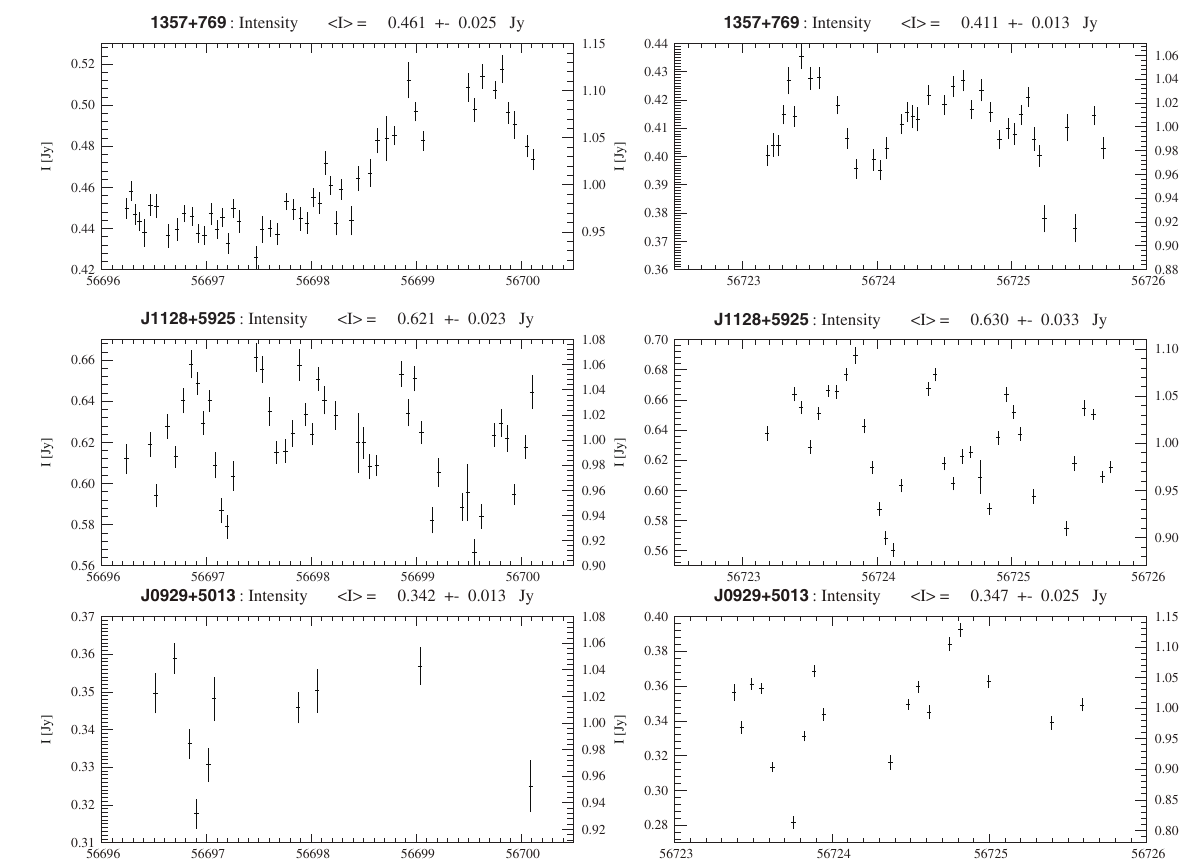
Figure 1. Three strong IDV sources with m 3 in both observations. ( Left upper panel ) the light curve of 1357 + 769 at ≥ 4.8 GHz in 8–12 February 2014, the flux density I (left y -axis) and the ratio of flux density over mean flux density < I > (right y -axis) versus time (MJD) in this and following figures; ( right upper panel ) the light curve of 1357 + 769 at 4.8 GHz in 7–9 March 2014. ( Left middle panel ) the light curve of J1128 + 5925 at 4.8 GHz in 8–12 February 2014; ( right middle panel ) the light curve of J1128 + 5925 at 4.8 GHz in 7–9 March 2014. ( Left bottom panel ) the light curve of J0929 + 5013 at 4.8 GHz in 8–12 February 2014; ( right bottom panel ) the light curve of J0929 + 5013 at 4.8 GHz in 7–9 March 2014.